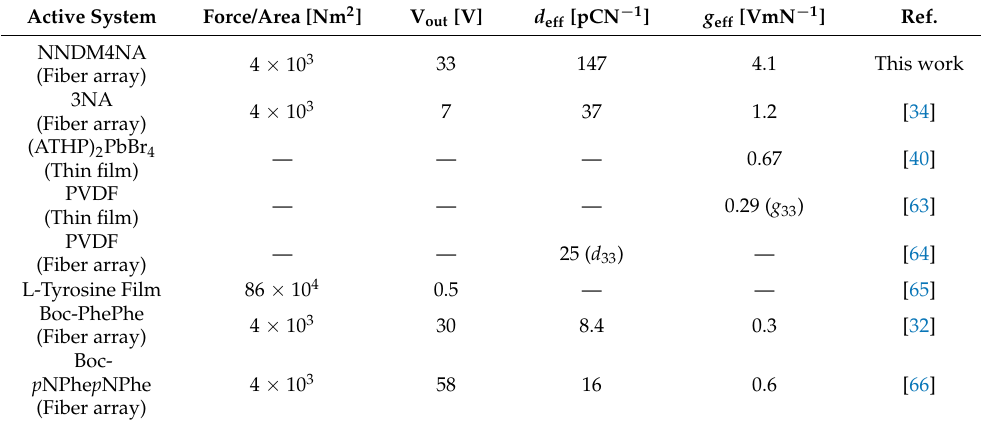
Table 2. Piezoelectric output quantities for selected all-organic electrospun nanofiber array.